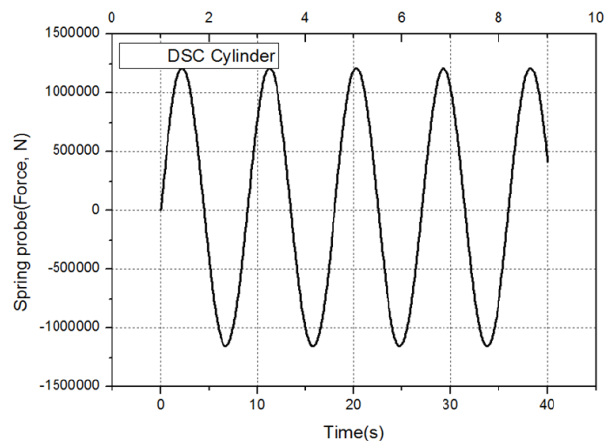
Figure 12. Load of the DSC cylinder.